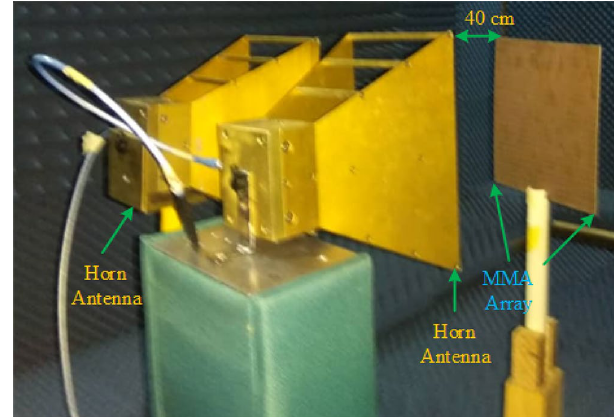
Figure 23. Array measurement procedure of the MAA.